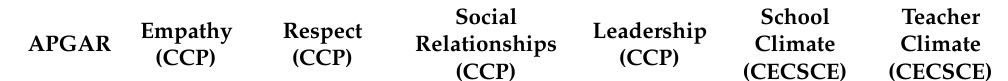
Table 1. Descriptive data and correlation matrix between Family Functionality, Prosocial Behaviour and School Climate ( N =